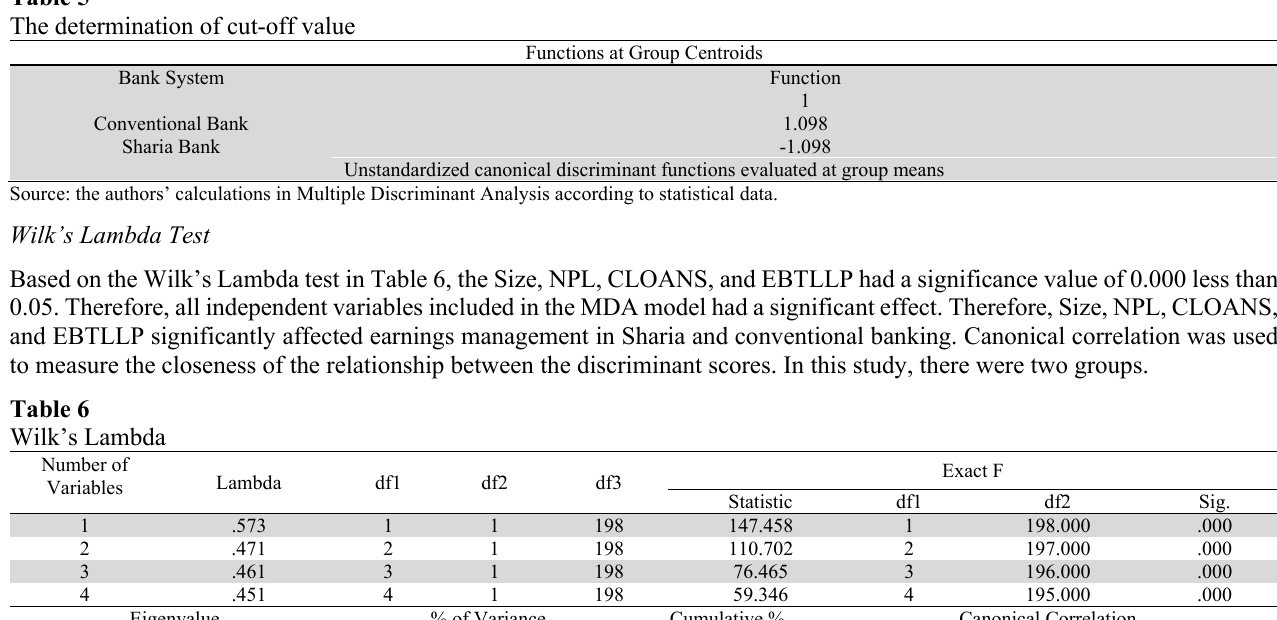
The determination of cut-off value Bank System